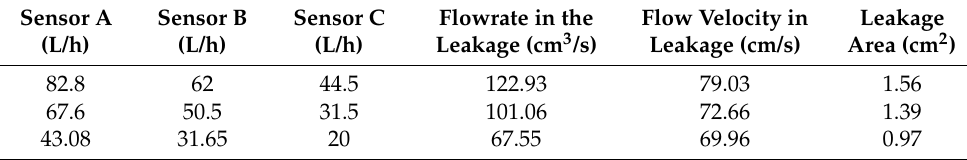
Table 3. The result of the size of leakage by the flowrate of sensors for Type